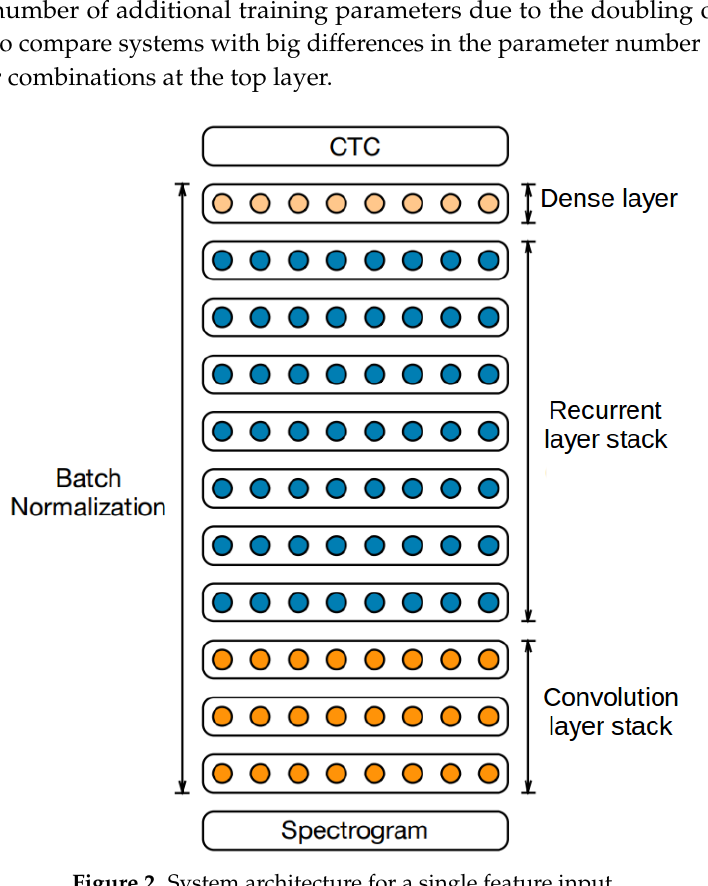
Figure 2. System architecture for a single feature